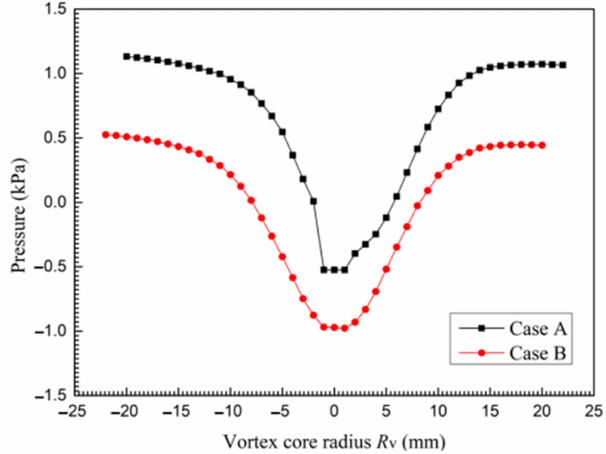
Figure 12. Variation curve of the pressure in the vortex core with the radius of the vortex